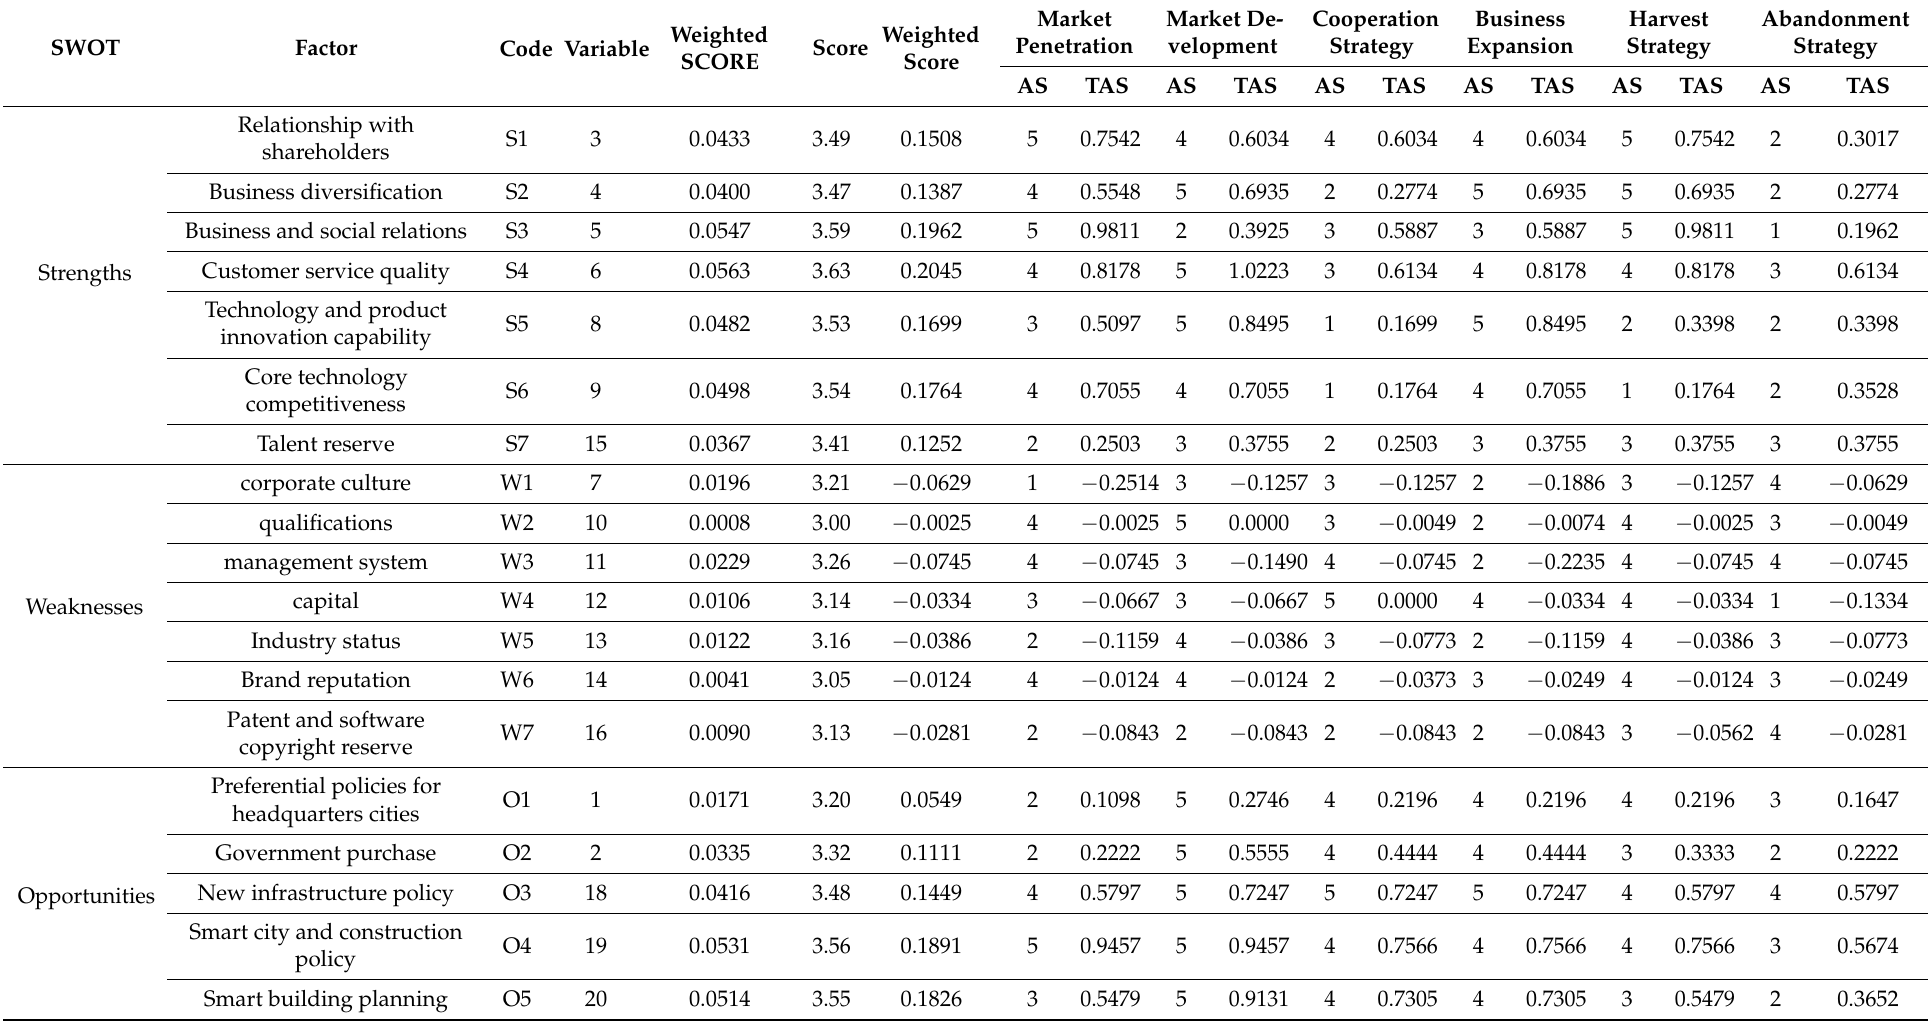
Table 4. Analysis of alternative strategy options based on